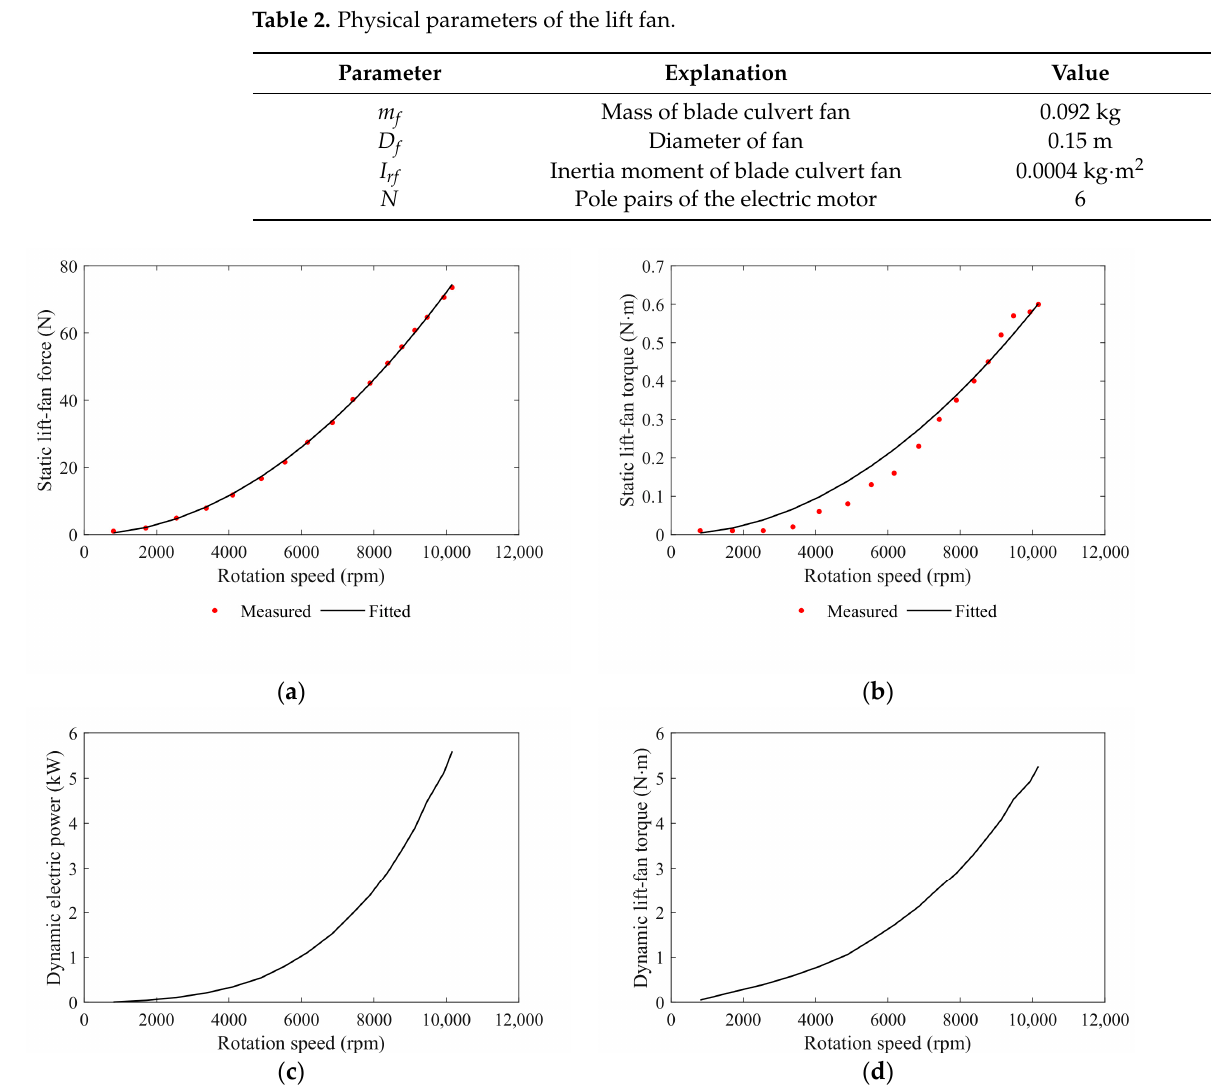
Figure 3. Bench test results for lift fans. ( a ) Lift fan static force test results and fitting curve; the estimated results are C t = 4.2278. ( b ) Lift fan static torque test results and fitting curve; the estimated results are C q = 0.2303. ( c ) Recorded dynamic electric power change with rotation speed. ( d ) Calculated results of the dynamic lift-fan torque. Table 2. Physical parameters of the lift fan.